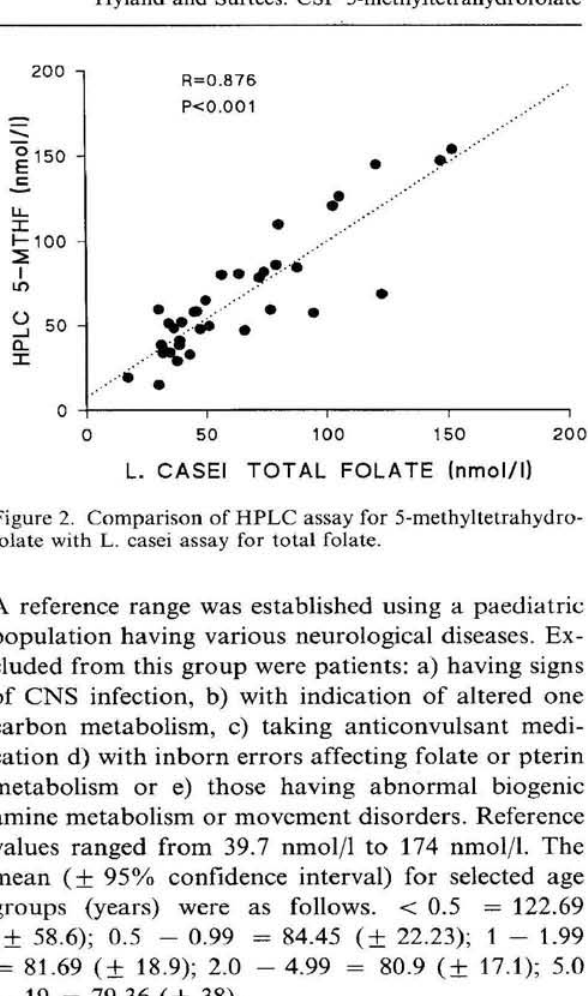
Figure 1. Electrochemical detection of 5-methyltetrahydrofol- ate. A = 100 nmol/1 standard. Β = Normal cerebrospinal fluid. C = cerebrospinal fluid from a patient with 5,10-methylenete- trahydrofolate reductase deficiency. Injection volume = 20 μΐ.